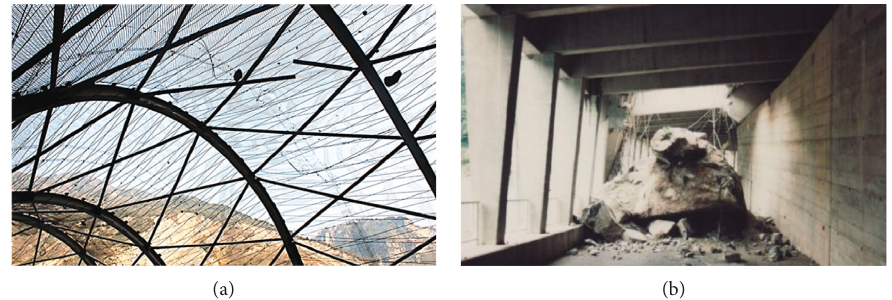
Figure 2: Failed rock shed. (a) Flexible rock shed. (b) RC rock shed